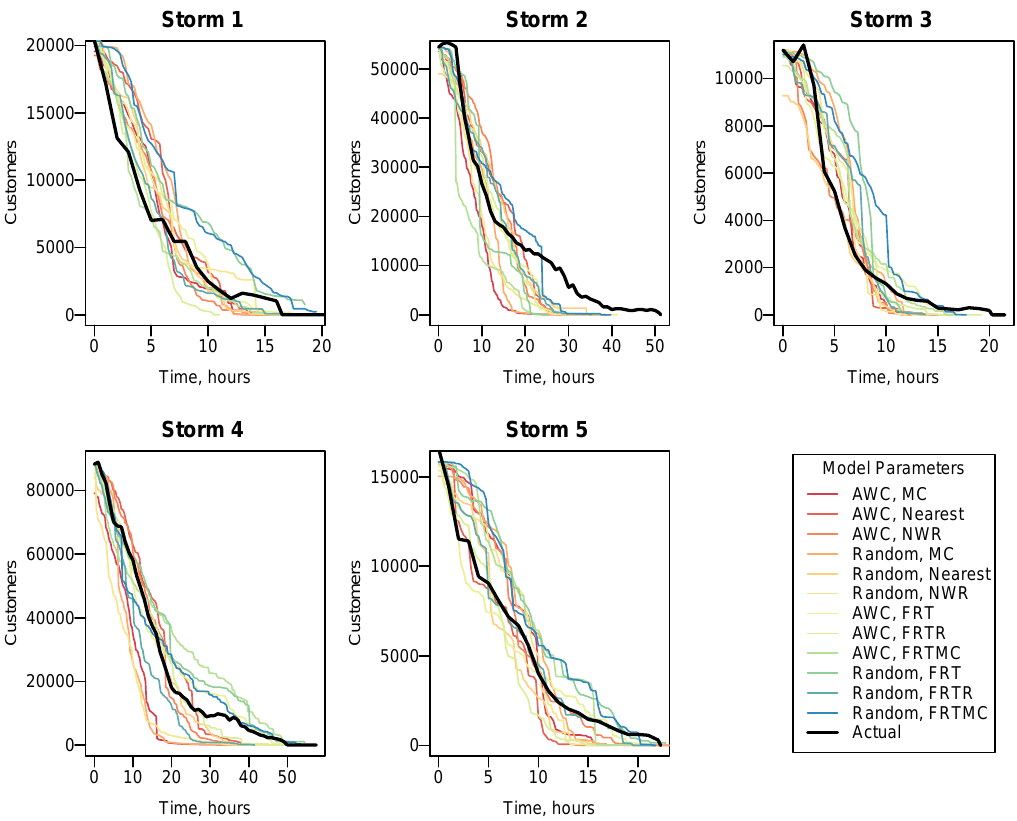
Figure 2. Variation of model parameters for validation storms. Crew start location and search strategy are indicated. Travel speed set to 25 mph, the total number of crews and percent working during each shift shown in Table 1., repair time range for each storm shown in Table 2. Number of outages and total customers affected for each storm shown in Table 1. MC is most customers affected, NWR is nearest with radius, FRT is fastest repair time, FRTR is fastest repair time within radius and FRTMC is fastest repair time with most customers affected. Table 2. R 2 , MAE and standard deviation of the top 3 combinations of modeled restoration curves for each storm from Figure